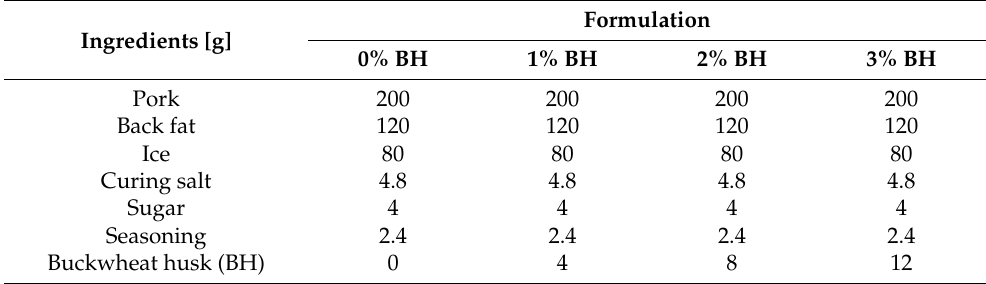
Table 1. Composition of sausages enriched with BH